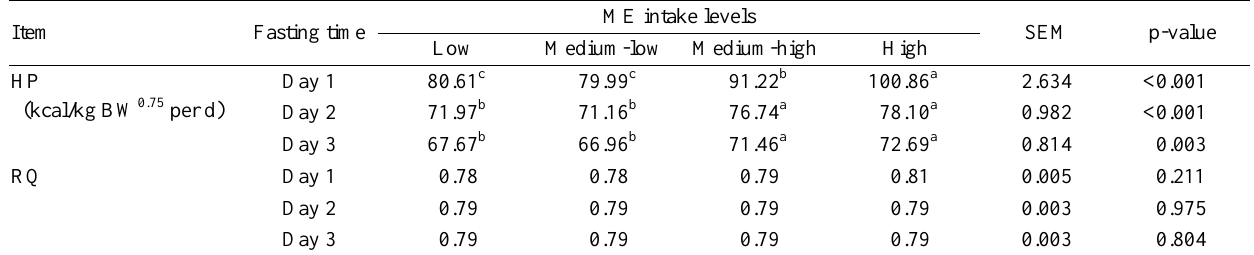
Table 3. Effect of ME intake levels on heat production (HP) and respiration quotient (RQ) in laying hens at different fasting time Item